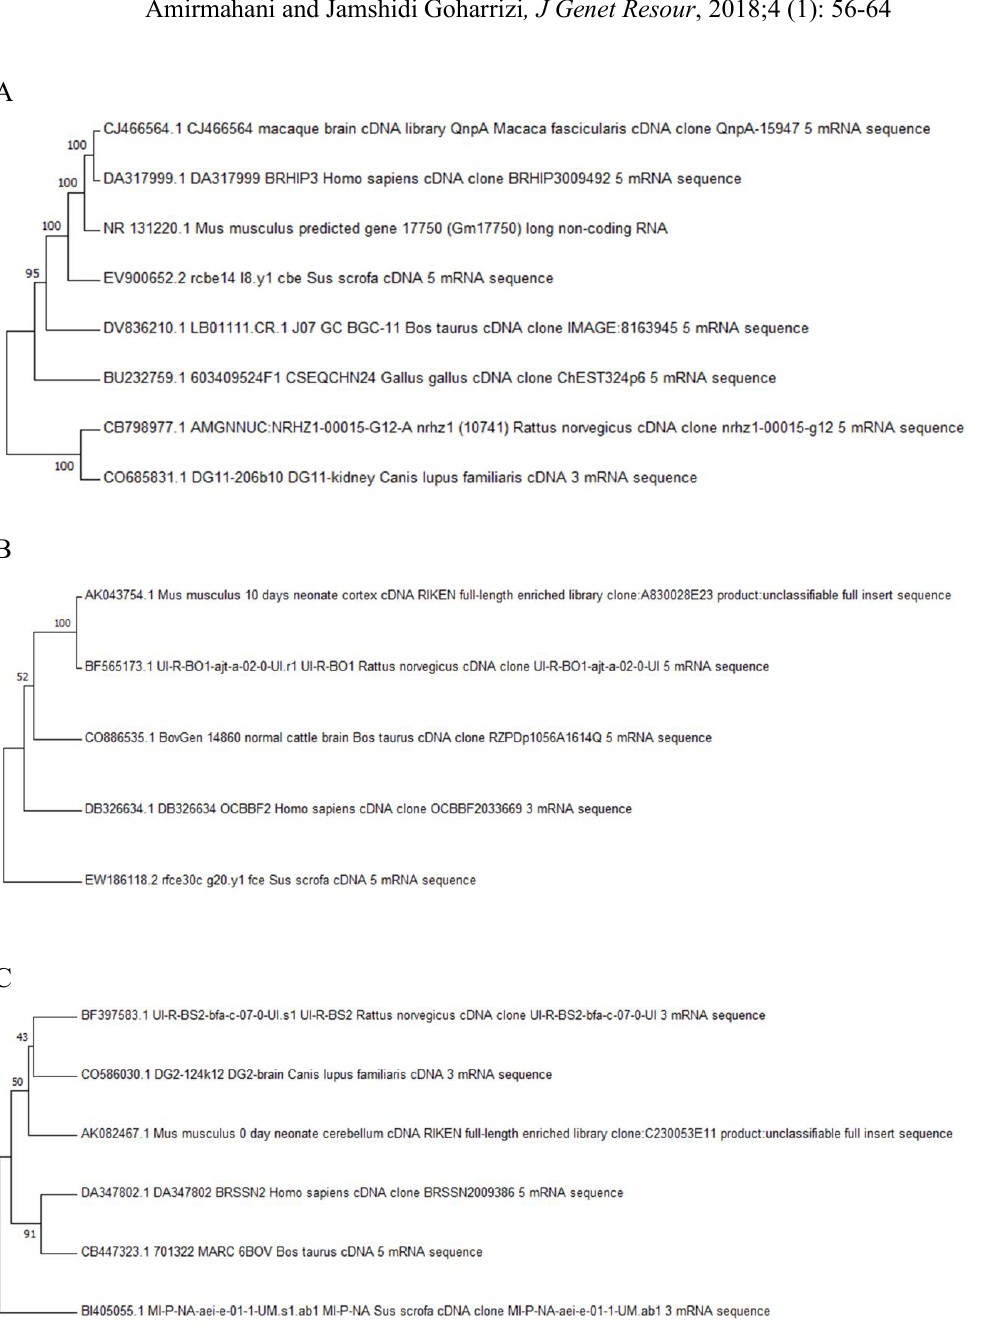
Fig. 2. Phylogenetic tree of the three lncRNA genes. The numbers at each node are the bootstrap support values obtained by maximum likelihood: (A) AK082072; (B) AK043754; (C)